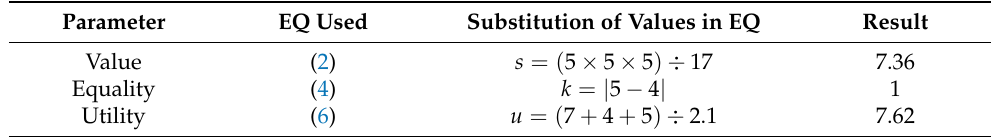
Table 5. Definition of satisfaction parameters named as value, equality, and utility.